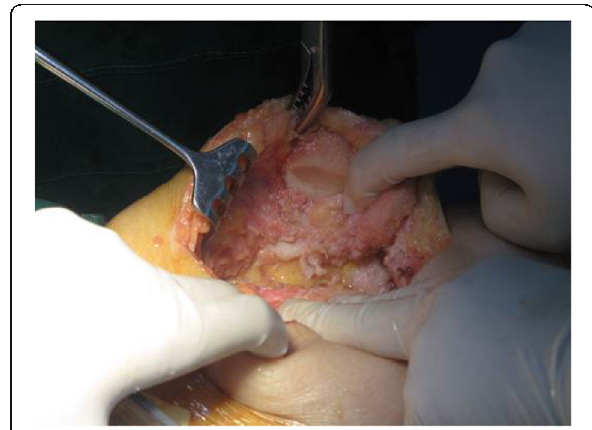
Fig. 5 If lateral patellar tilt or maltracking was present, the lateral patellar retinaculum was